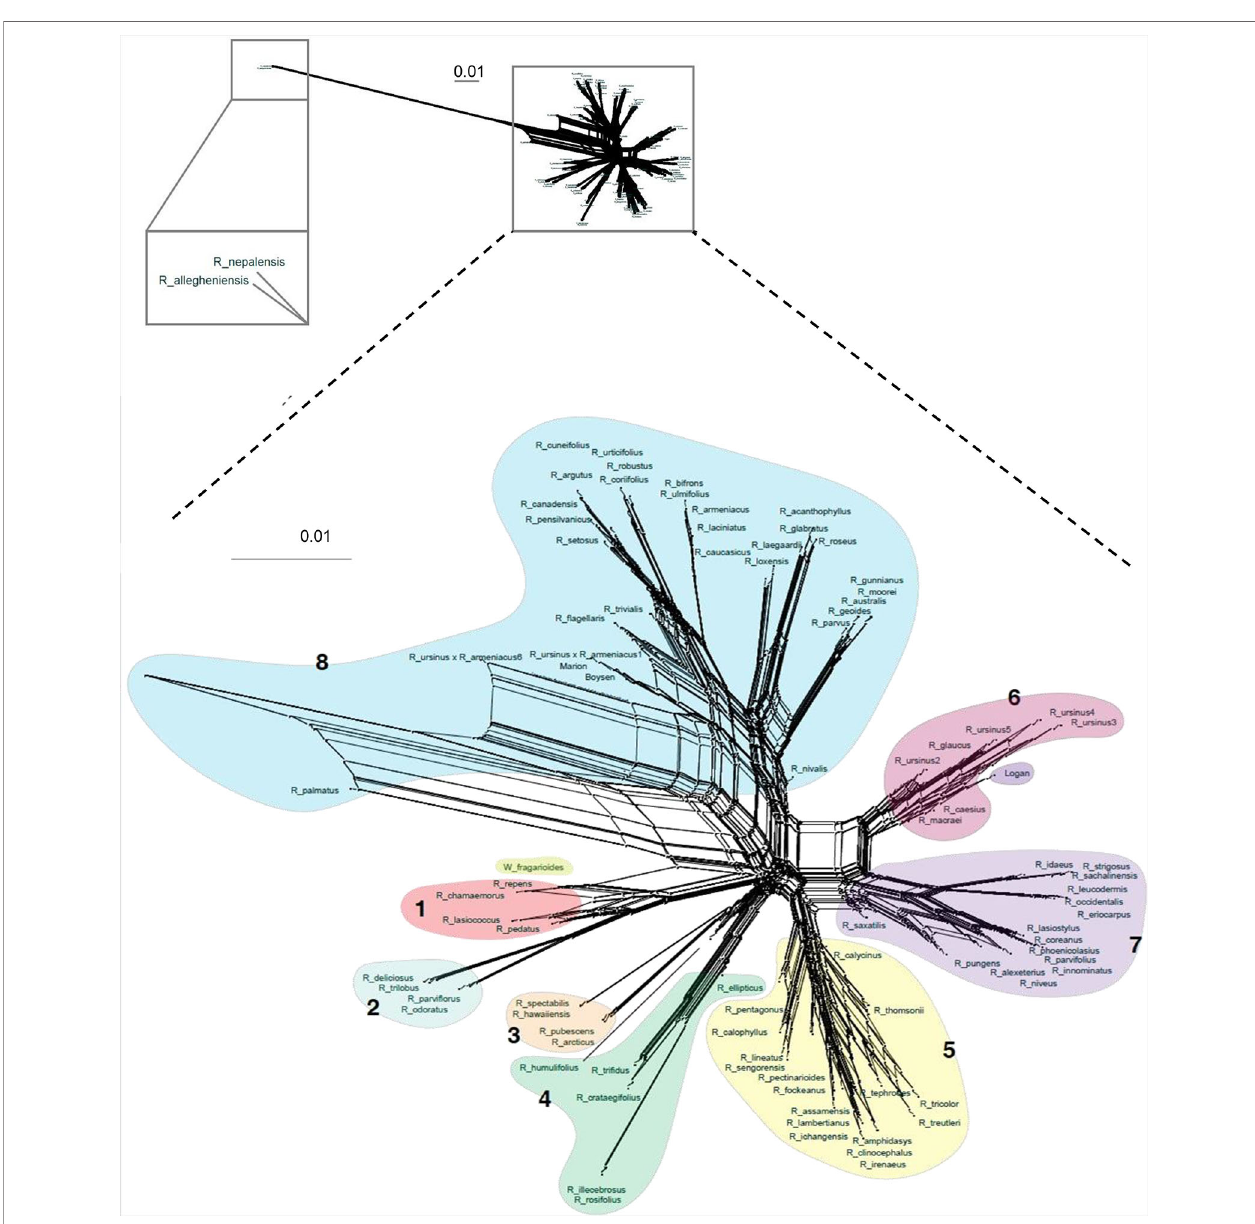
FIGURE 3 | Super network for all Rubus taxa estimated with SuperQ from exon gene trees estimated with RAxML. Colored shapes correspond to Groups 1 – 8. Top inset placement of R. allegheniensis and R. nepalensis due to limited sequence data for these samples